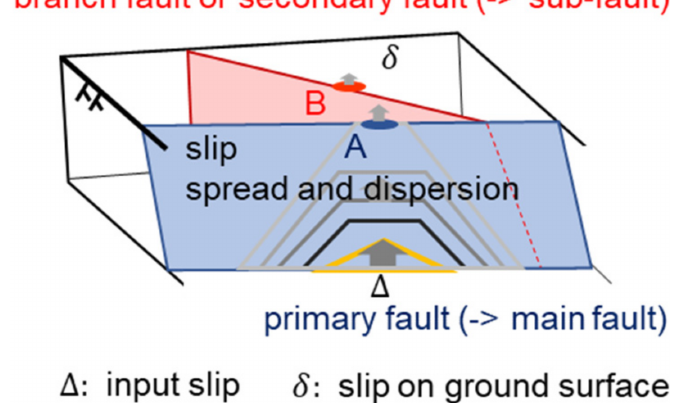
Figure 1. Spread and dispersion of fault